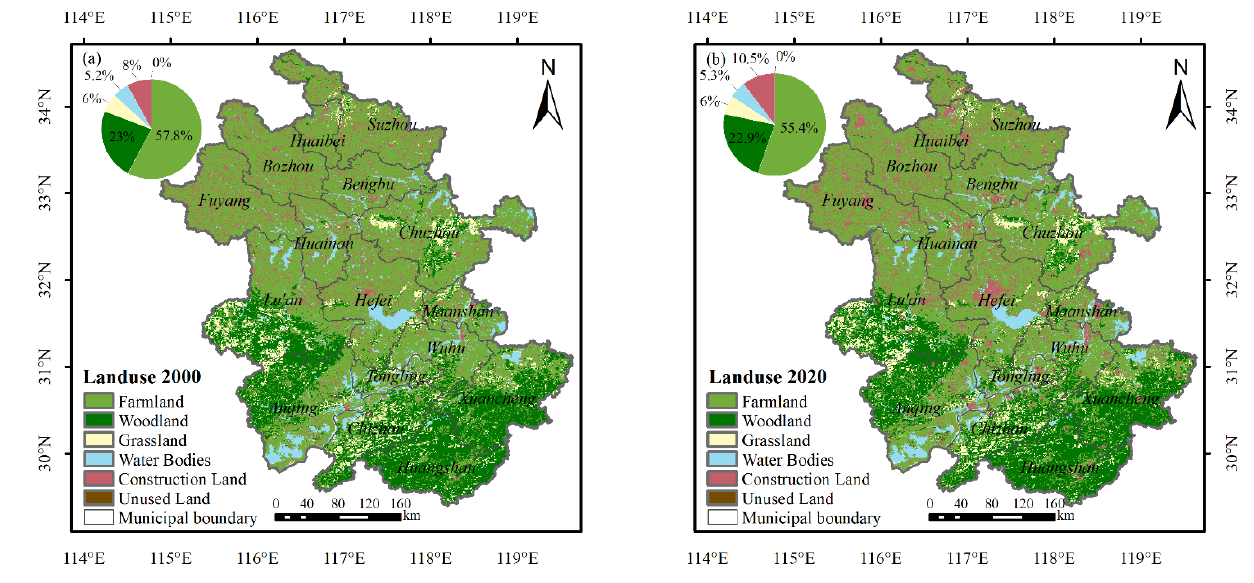
Figure 8. Land use in Anhui Province in ( a ) 2000 and ( b ) 2020. Table 4. Area transfer matrix of land-use changes in Anhui Province during 2000–2020 (km 2 ).